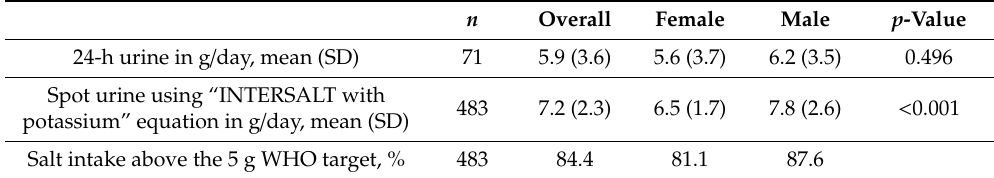
Table 2. Weighted results for salt